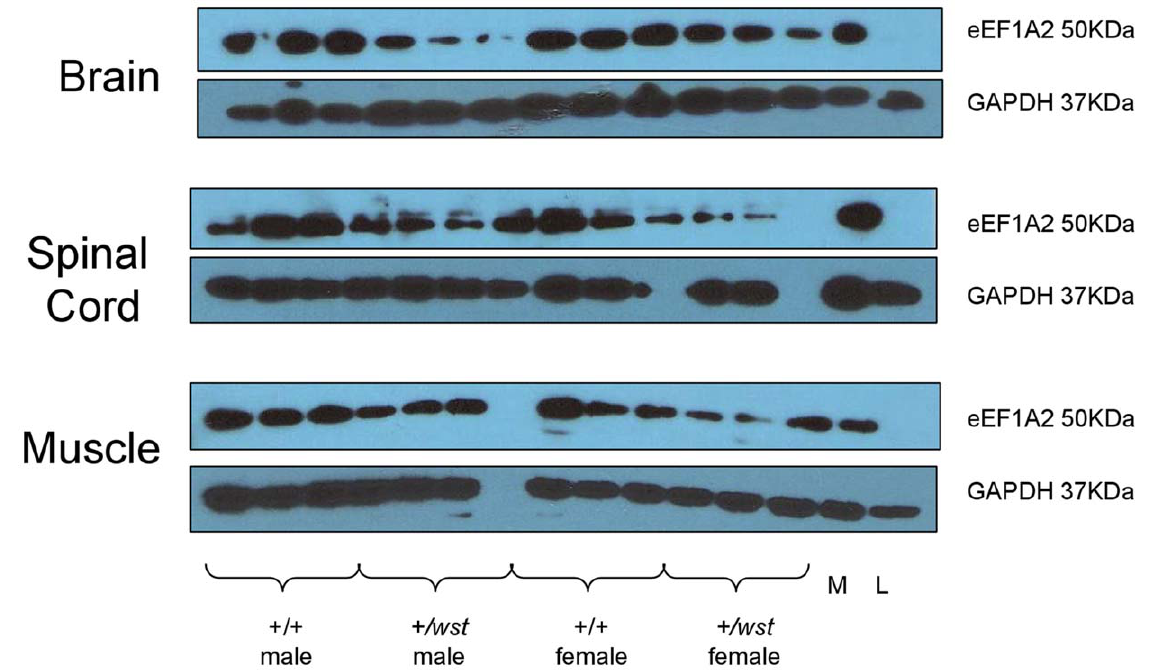
Figure 5. Protein expression in aged mice. Western blots showing protein expression of eEF1A2 and GAPDH (as a loading control) of animals from the ageing cohort. Three 21month old animals from each group are shown. WT indicates wild-type animals, HET indicates heterozygous animals, M indicates a muscle sample (as an eEF1A2 positive control) and L indicates a liver sample (an eEF1A2 negative control), both from wild-type mice.